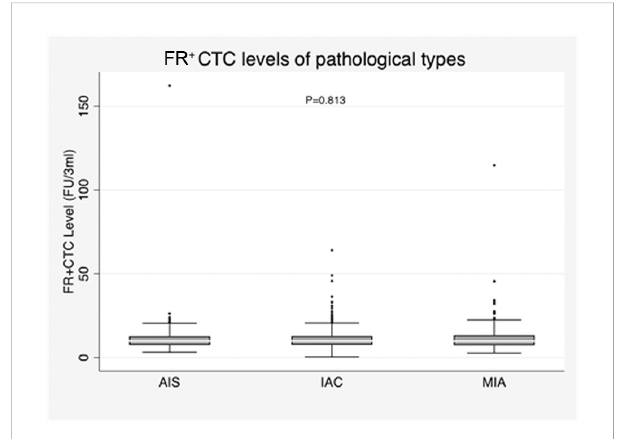
FIGURE 2 Correlation of FR + CTC level with pathological type across all included